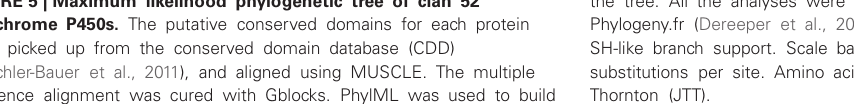
the tree. All the analyses were performed at the online platform Phylogeny.fr (Dereeper et al., 2008, 2010). Numbers at nodes indicate SH-like branch support. Scale bar indicates number of amino acid substitutions per site. Amino acid substitution model John Taylor Thornton (JTT).